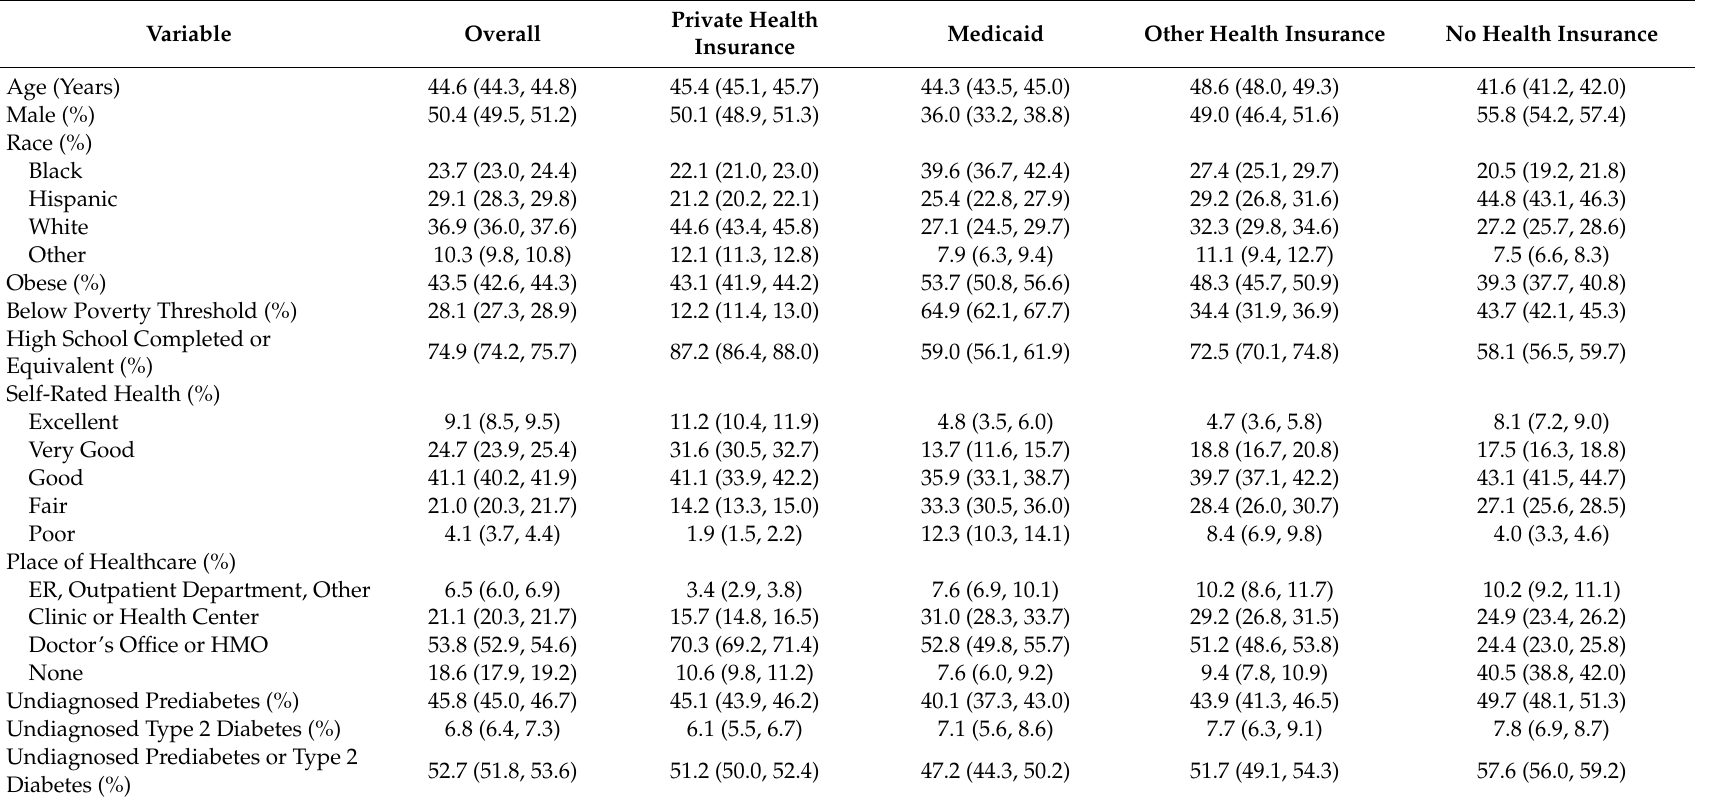
Table A1. Means and 95% confidence intervals for the descriptive characteristics of the